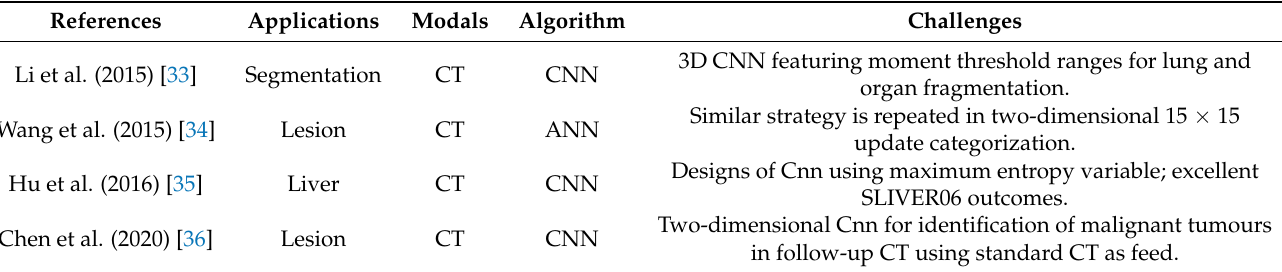
Table 4. Segmentation tasks in kidney